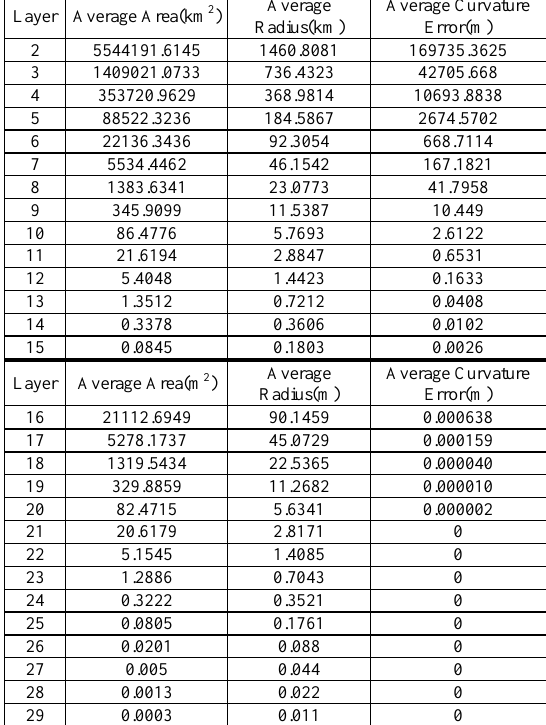
Table 1. The average area, average radius and average curvature error of cells on A4HCI hexagon